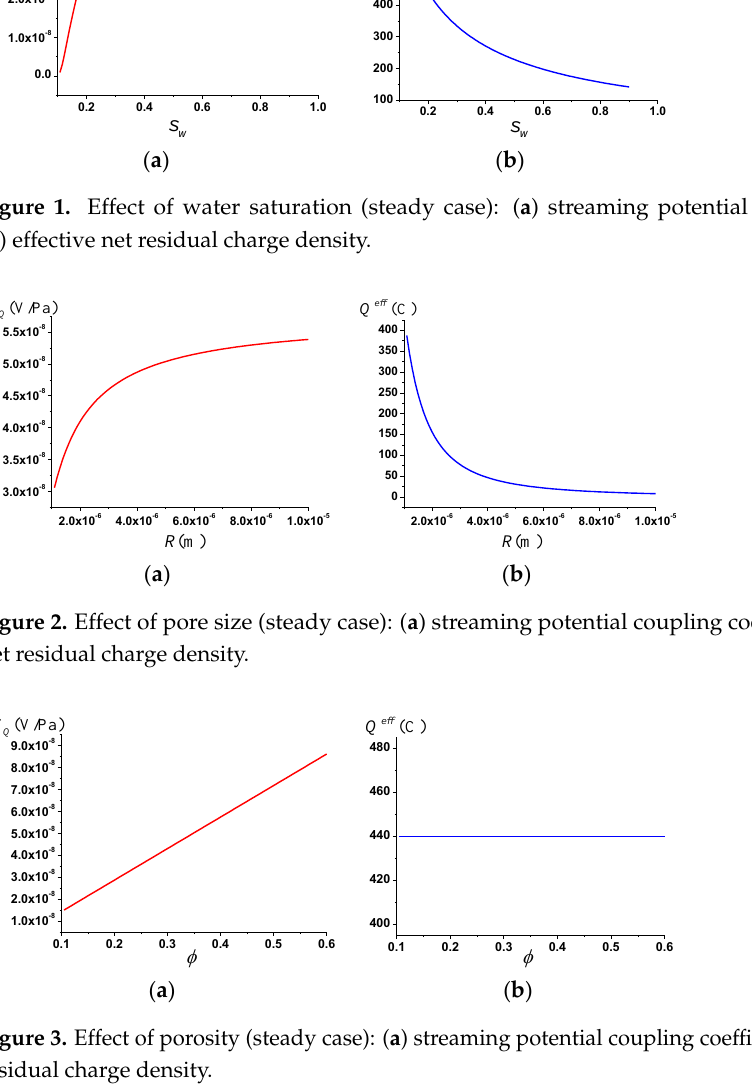
Figure 3. Effect of porosity (steady case): ( a ) streaming potential coupling coefficient; ( b ) effective net residual charge density.